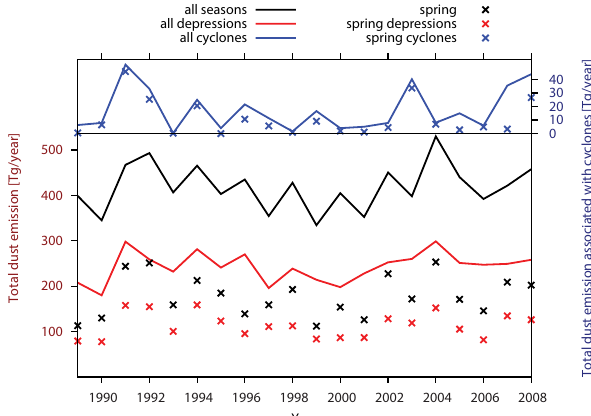
Figure 7. Dust source activation frequency based on satellite obser- vations and ERA-Interim data. The dust source activation frequency (DSAF) is the number of dust emission events per time. Shown is the annual mean DSAF derived from SEVIRI satellite observa- tions by Schepanski et al. (2007, 2012) in steps of 5% (black con- tours) and based on the dust emission model by Tegen et al. (2002) driven by the near-surface wind speed and soil moisture from 3- hourly ERA-Interim forecasts (shaded). Dust emission events larger than 10 − 5 gm − 2 s − 1 are considered from the dust model only, as smaller dust amounts are unlikely to be detected in the satel- lite product (Laurent et al., 2010). The time period considered is March 2006 to February 2010 following the satellite observation. Grey contours show the orography in steps of 200m.